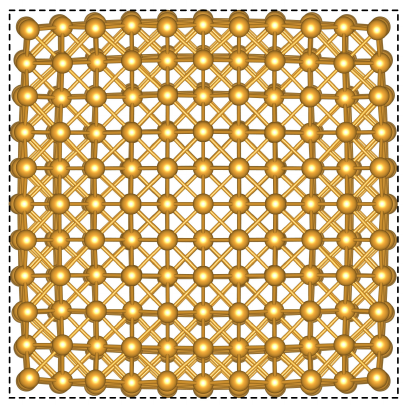
Figure 1. Relaxed structure of a nanocube with side a = 2.035nm (666 atoms). The dashed line is a guide for the eye showing an ideal square shape.